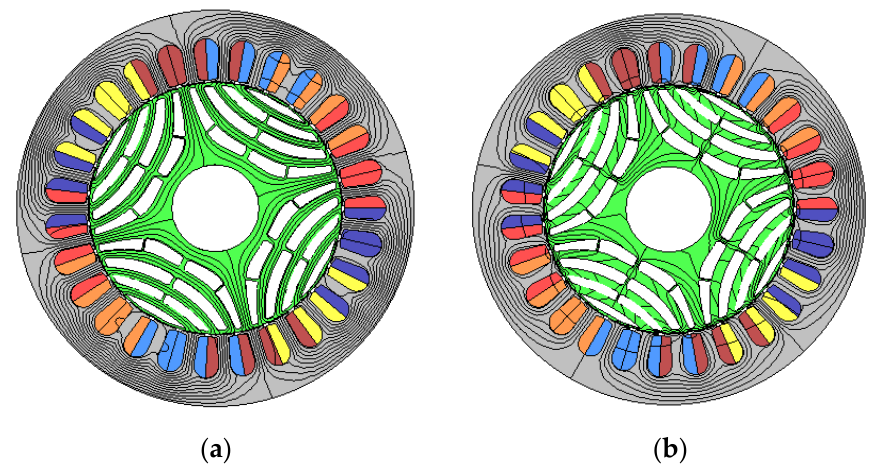
Figure 4. Magnetic field in machine: ( a ) flux lines for d-axis MMF — 0 degrees current angle; ( b ) flux lines for q -axis MMF — 90 degrees current angle .